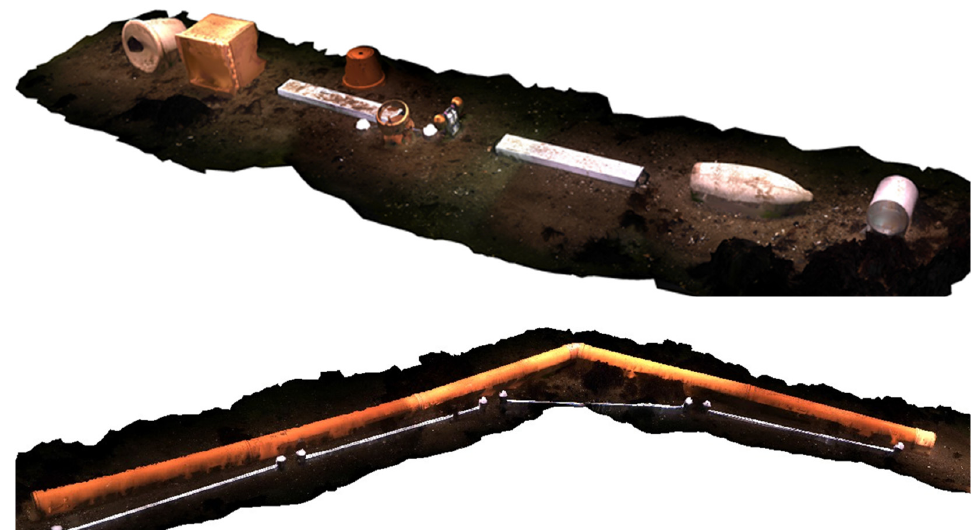
Figure 3. Reconstructed areas with test objects using the color camera data ( above ) and approximately a ten-meter-long pipe segment ( below ).